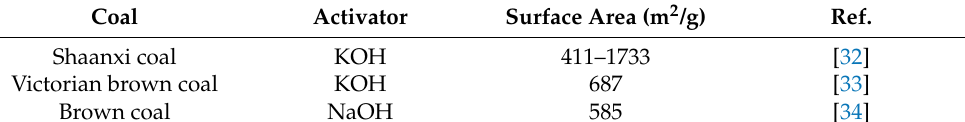
Table 3. BET analysis results of MCAC adsorbent. Table 4. Cont.